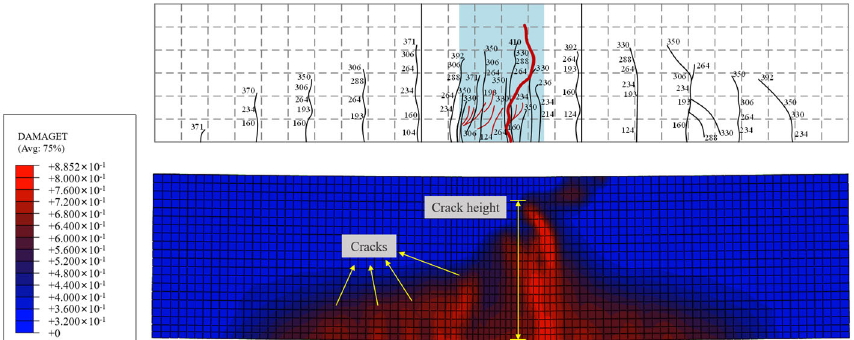
Figure 17. Comparison of failure mode between test and simulation.